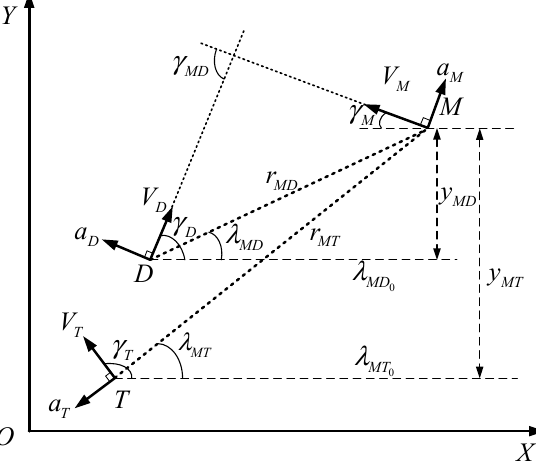
Figure 1. Active aircraft defense